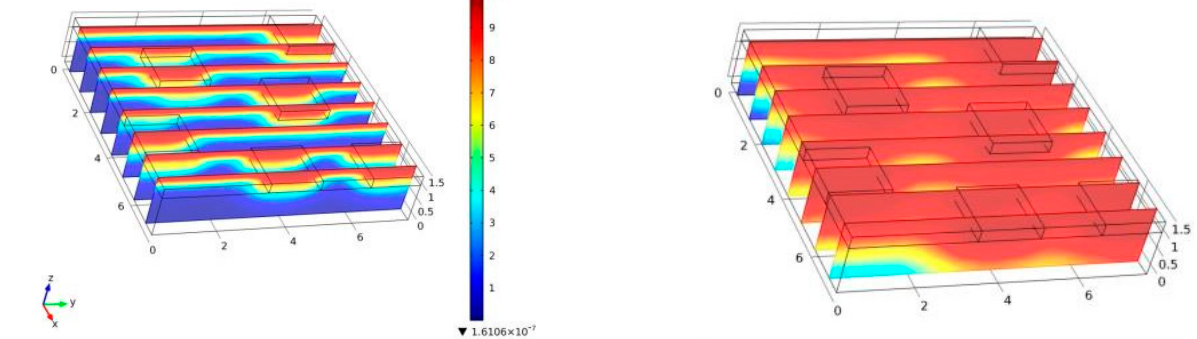
Figure 8. Simulated adsorbed phosphorus concentrations in fly ash-sand BRC; ( left ) at 20 years, ( right ) at 144 years [41].